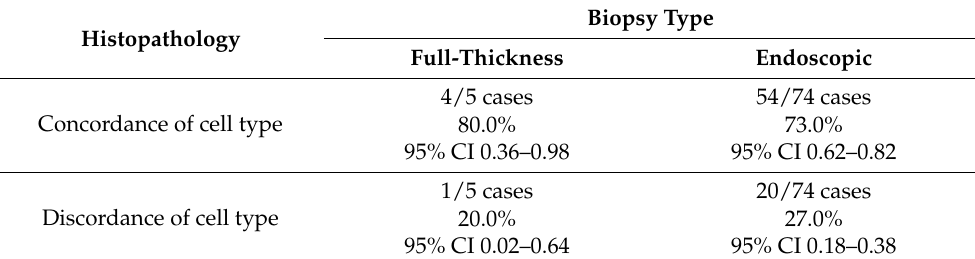
Table 4. Concordance and discordance of cell type between duodenal and ileal biopsy specimens for each biopsy type: full-thickness biopsy (5 dogs) versus endoscopic biopsy (74 dogs) with 95% confidence intervals (CI)